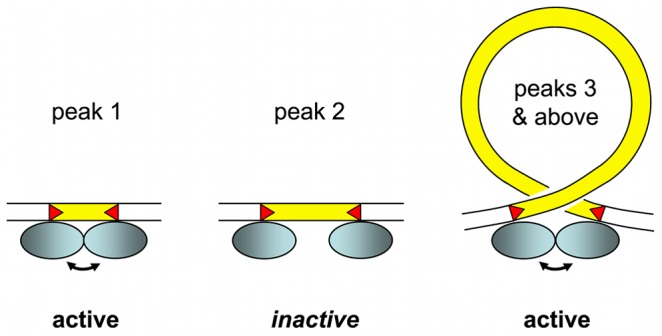
IES size constraint and the assembly of an active excision complex.Our working model is based on the assumption that oligomerization of the IES excisase (most likely the domesticated transposase PiggyMac) on DNA activates catalytic cleavage at IES ends (IESs are drawn in yellow and red triangles highlight the orientation of their ends). In the absence of any information on the stoichiometry of the complex, the excisase is represented by a shaded blue ellipse. For very short IESs from peak 1 (26–30 bp in length), the required contact between protein subunits may be established directly (double-headed arrow) and the complex is active. For IESs longer than 44 bp (peak 3 and above), we propose that looping of the intervening DNA double helix brings IES ends into close proximity and activates DNA cleavage. We have arbitrarily drawn the complex as an antiparallel arrangement of IES ends within a negatively supercoiled loop, but other conformations are possible. IESs from the “forbidden” peak 2 would be too long to allow direct contacts between protein subunits to be established, and too short to form an excision loop.